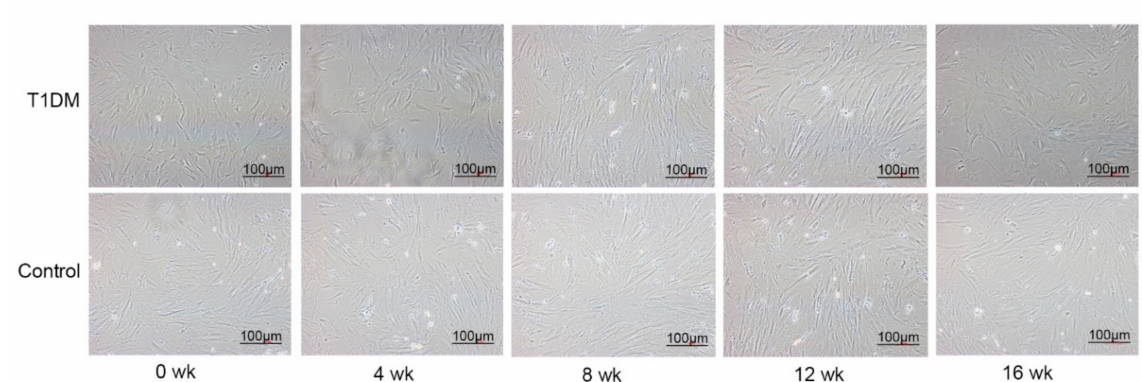
Figure 3. ASC morphology. ASCs collected at 0, 4, 8, 12, and 16 weeks after T1DM induction and from control rats at the same time points exhibited similar morphology. Magnification = 100 × .